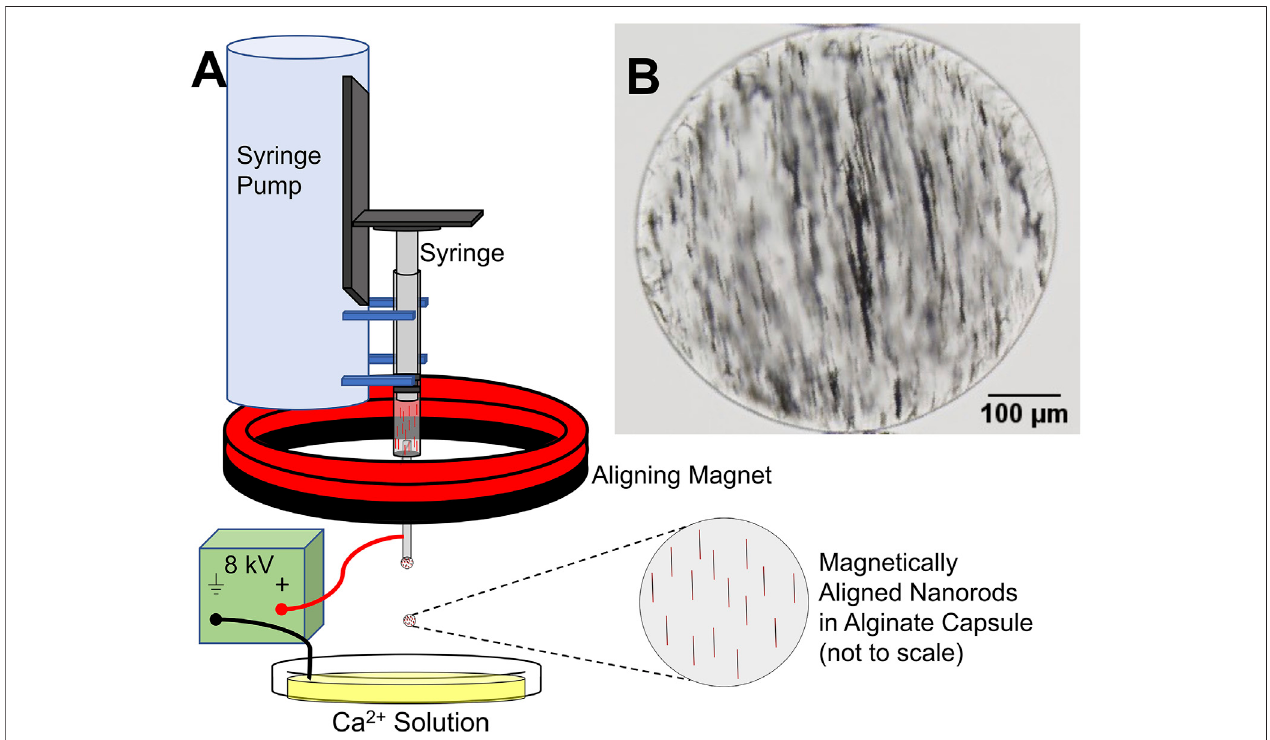
FIGURE 1 | MANiAC synthesis. (A) Syringe with pre-aligned nanorods in liquid alginate is loaded into syringe pump and extracted at a rate of 100 μ l/min. (B) MANiAC image.